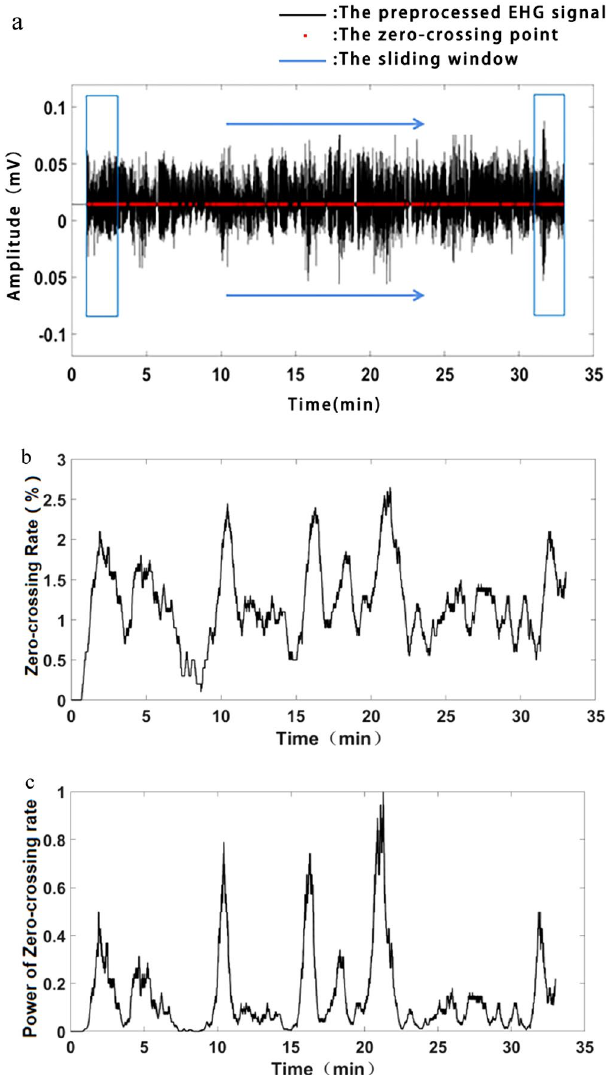
Figure 5. Strengthening of EHG burst. ( a ) A sliding window moving along the elevated EHG signal. The zero-crossing points are in red, and the sliding window is in blue. ( b ) The zero-crossing rate. ( c ) Power of zero- crossing